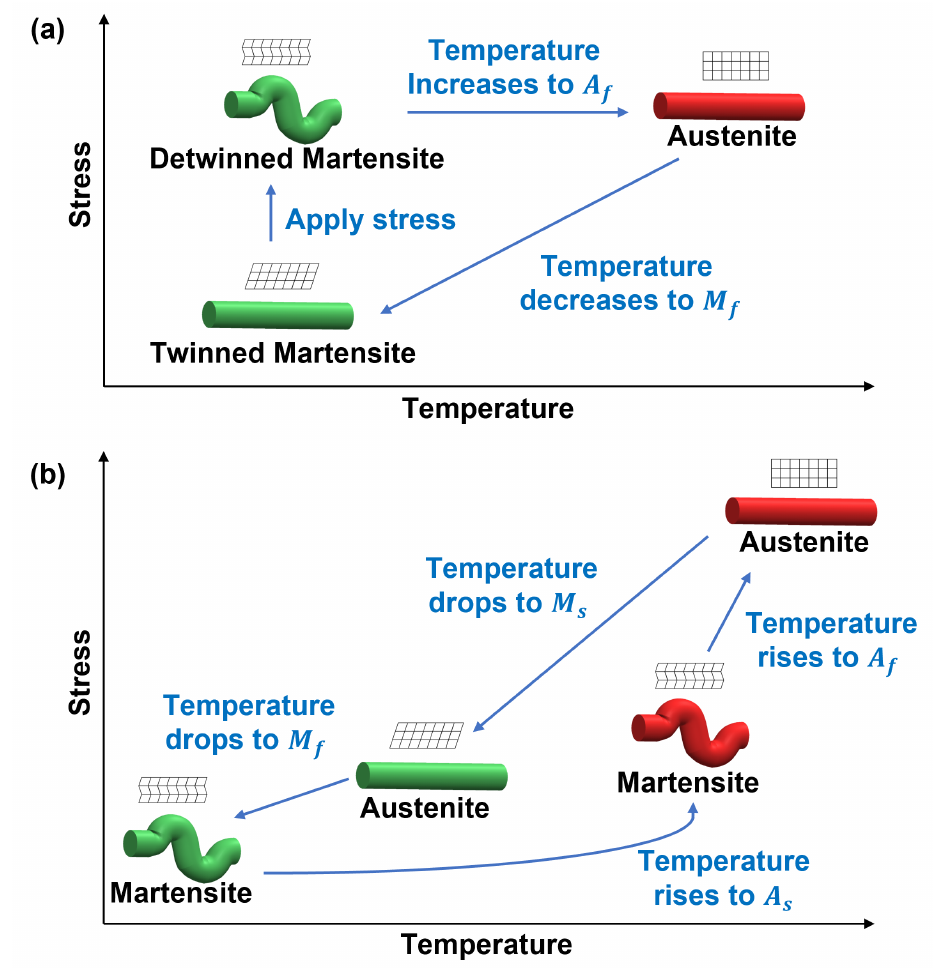
Figure 2. ( a ) Phase shift of one-way SMA and ( b ) phase shift of two-way